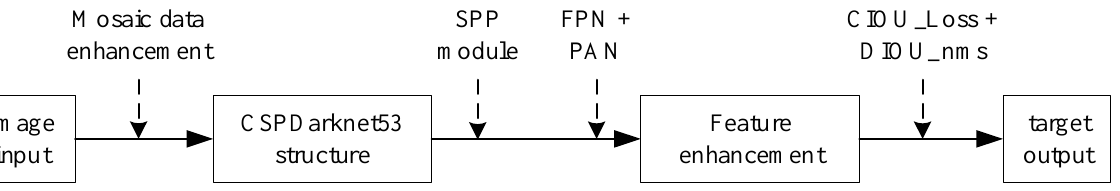
Figure 3. Detection scheme for enhanced object feature.